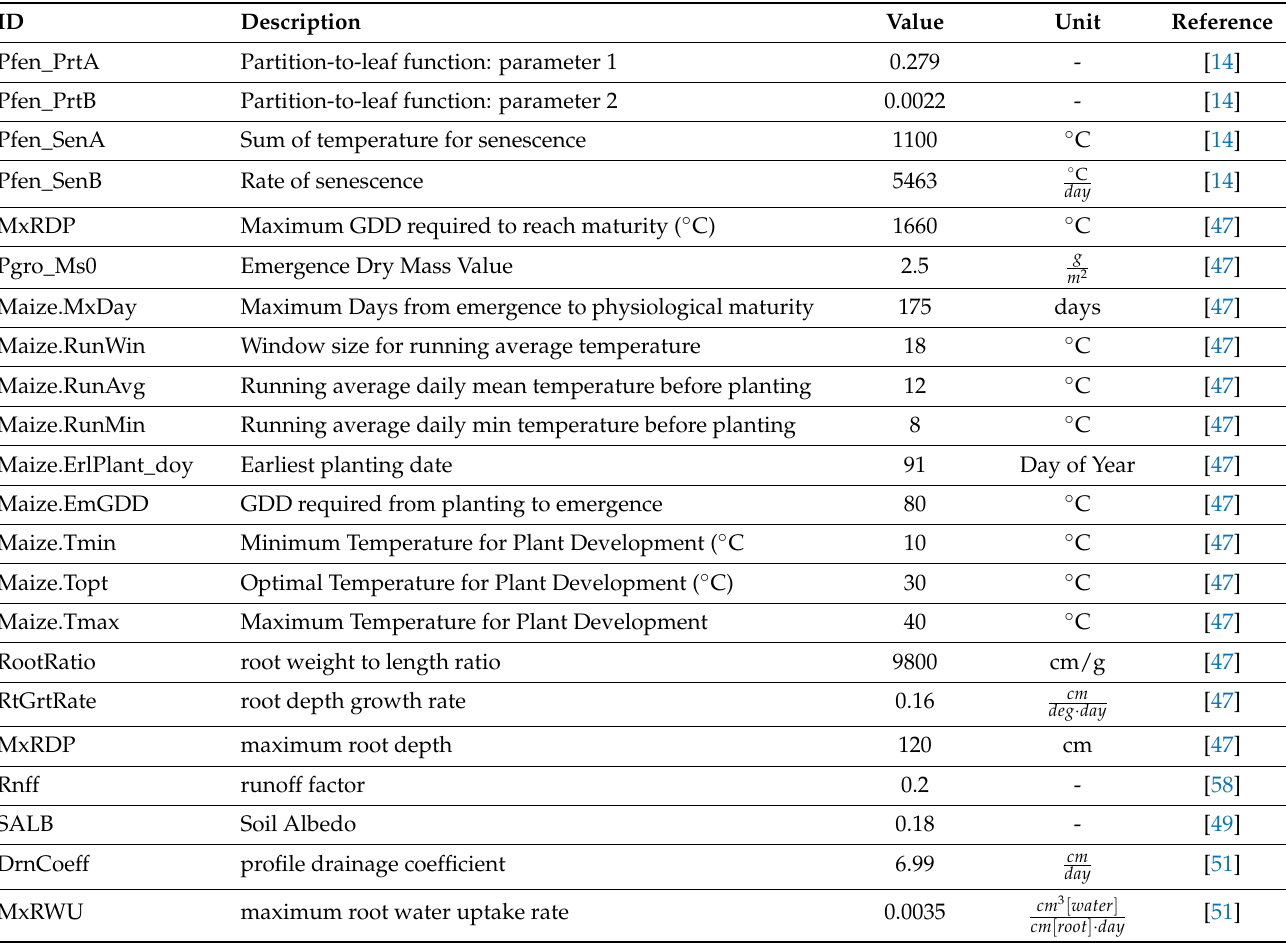
Table 4. List of model fixed parameters and their calibration